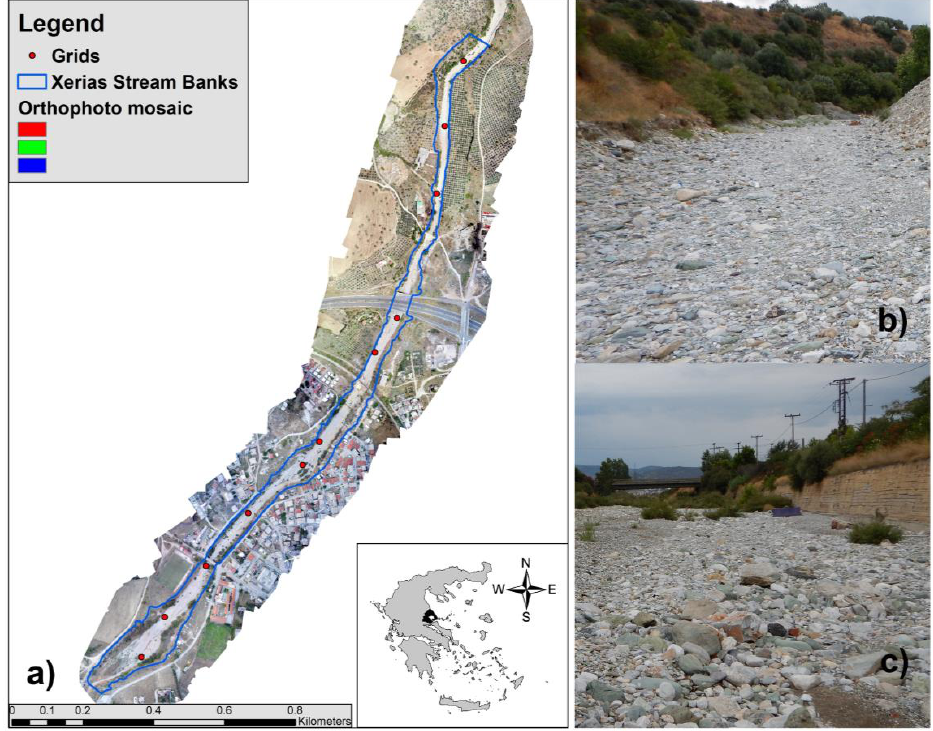
Figure 2. Xerias stream reach (red dots represent the location of the sampling grids) ( a ) and inhomogeneous bed composition ( b , c ).